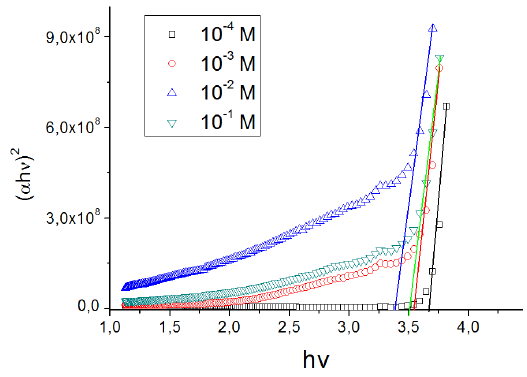
Fig. 6. Plot of (αhυ) 2 vs. hυ of the films at different concentrations: (a) 10 -4 M, (b) 10 -3 M, (c) 10 -2 M, (d) 10 -1 M.